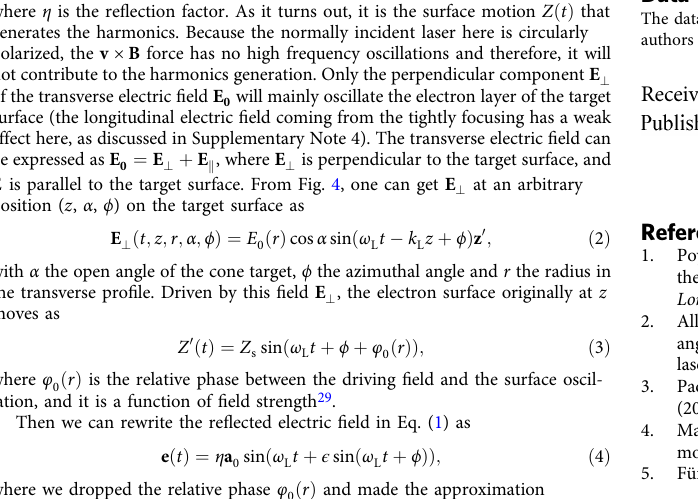
¼ E ð r Þ½ sin ð ω t (cid:2) k z Þ y þ cos ð ω t (cid:2) k z Þ x (cid:7) rotating in xy plane is decomposed into E 0 0 L L L L is decomposed again into E ? ¼ E y 0